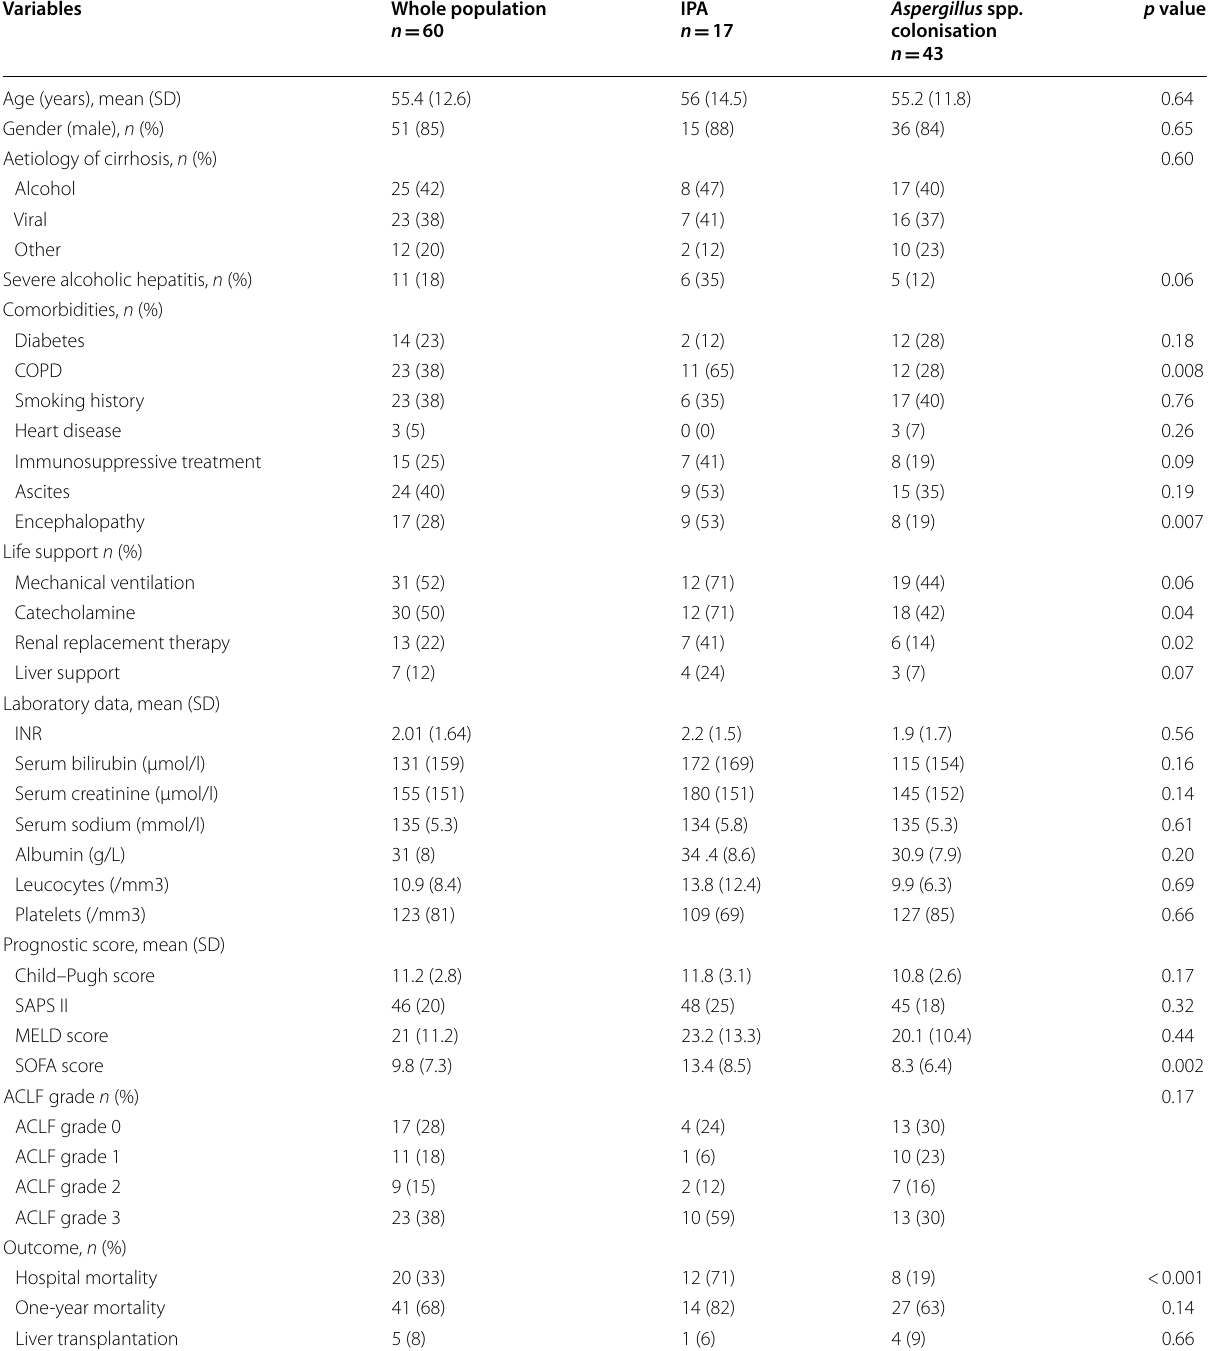
Table 2 Demographic, clinical and laboratory characteristics of patients with positive culture of Aspergillus spp., invasive pulmonary aspergillosis and Aspergillus spp.